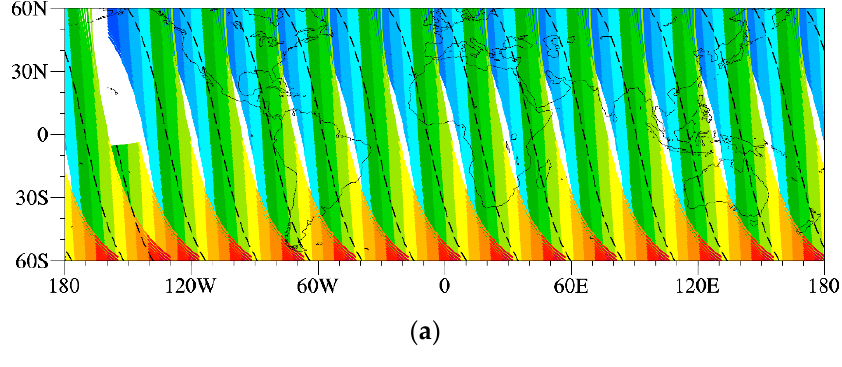
method’s 24 pairs.